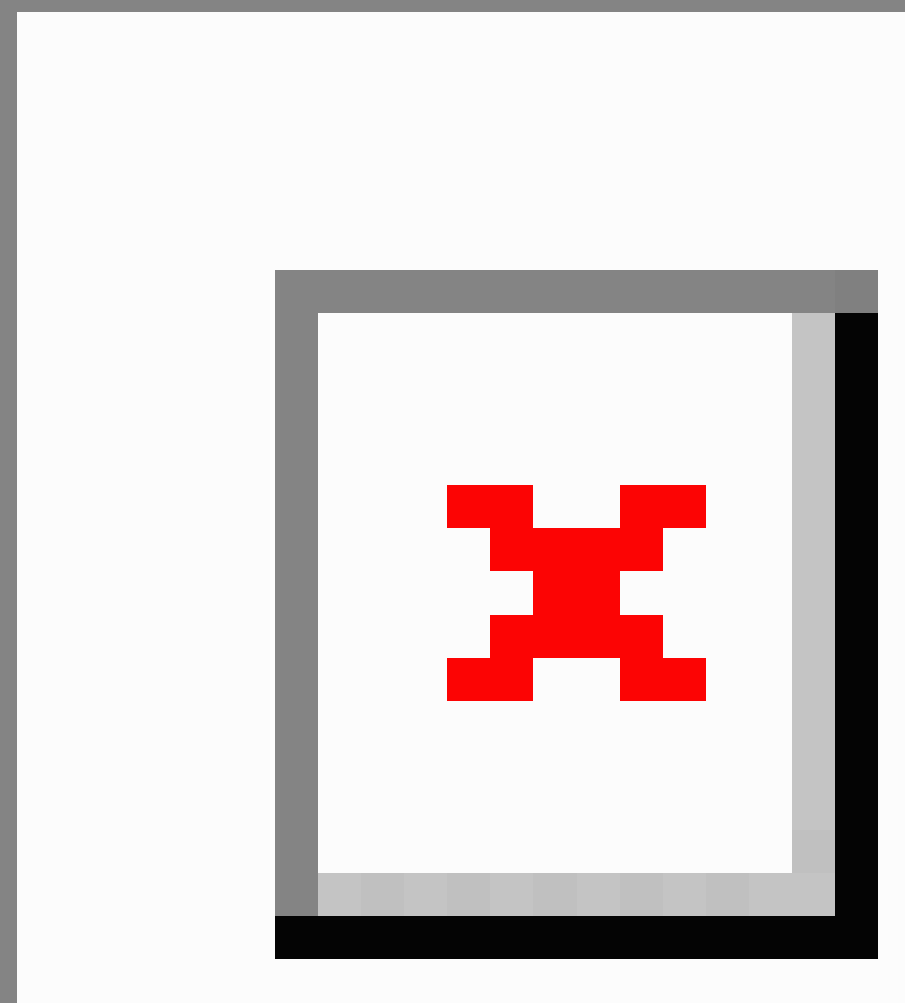
Figure 1. Our model’s receiver operating characteristic